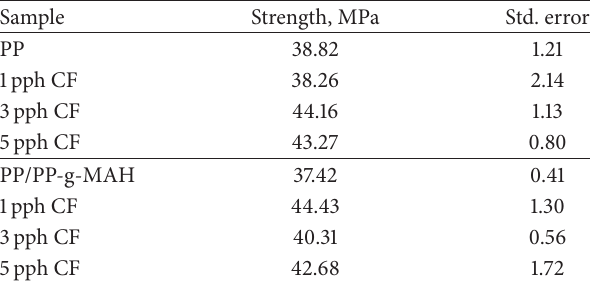
Table 5: Yield strength of the compression moulded